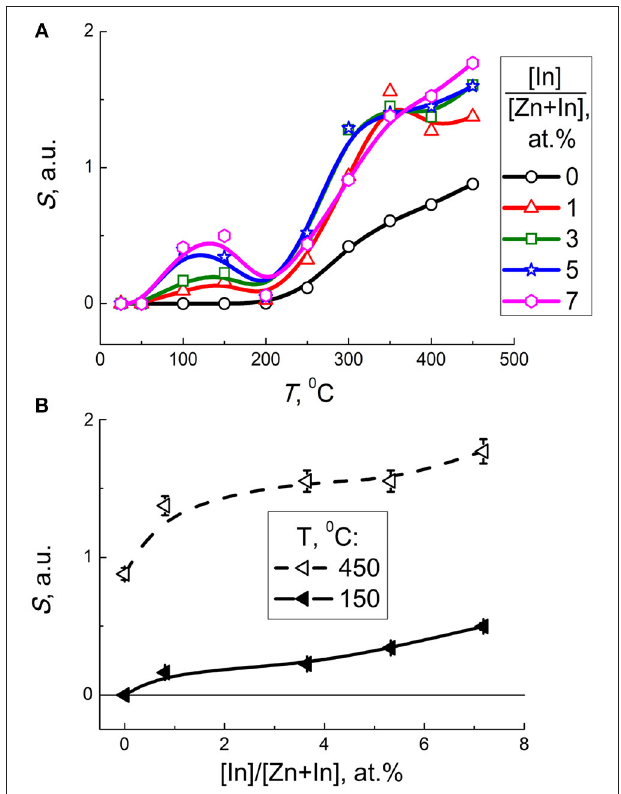
FIGURE 9 | (A) Sensor signal of zinc oxide modified by different amounts of In 2 O 3 to 5 ppm CO as a function of temperature. (B) Sensor signal of modified zinc oxide to 5 ppm CO at 150 ◦ C (solid lines) and 450 ◦ C (dashed lines) as a function of In